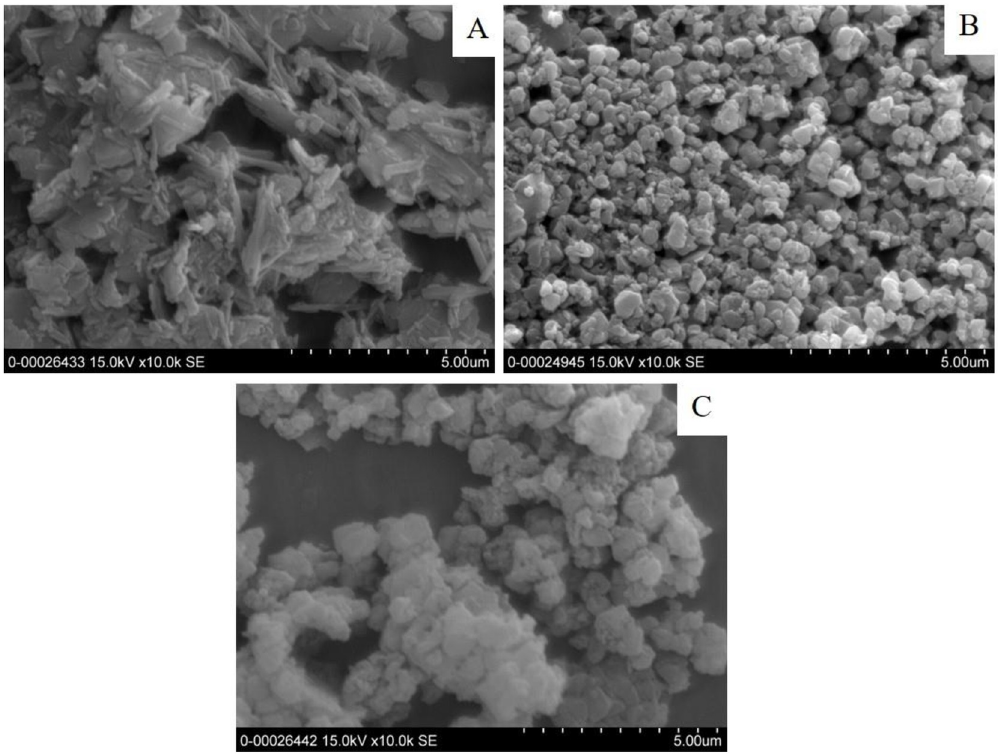
Fig 2. FE-SEM photomicrographs of materials (A) MK, (B) zeolite (Z) and (C) TiO 2 /zeolite (TZ).